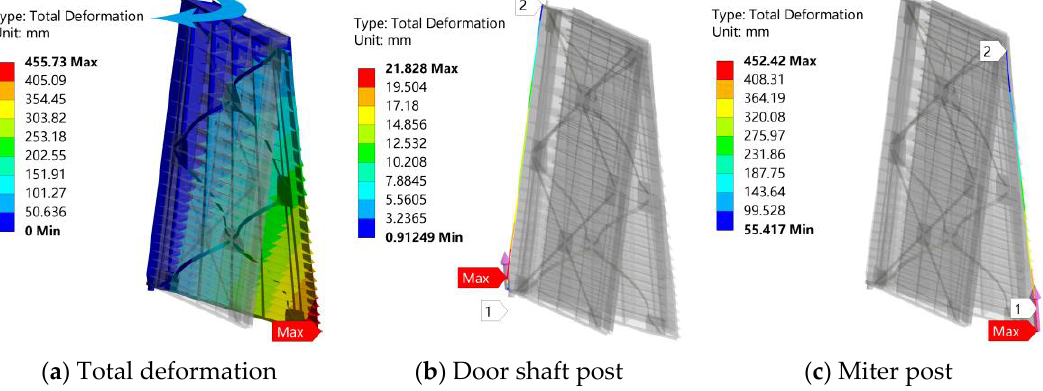
Figure 19. ( a ) Deformation of the overall gate, ( b ) Deformation of the door shaft column, and ( c ) Deformation of the mitered column under the door-closing condition. Table 6. The maximum deformation of the gate with and without back lever in the closed state mm.